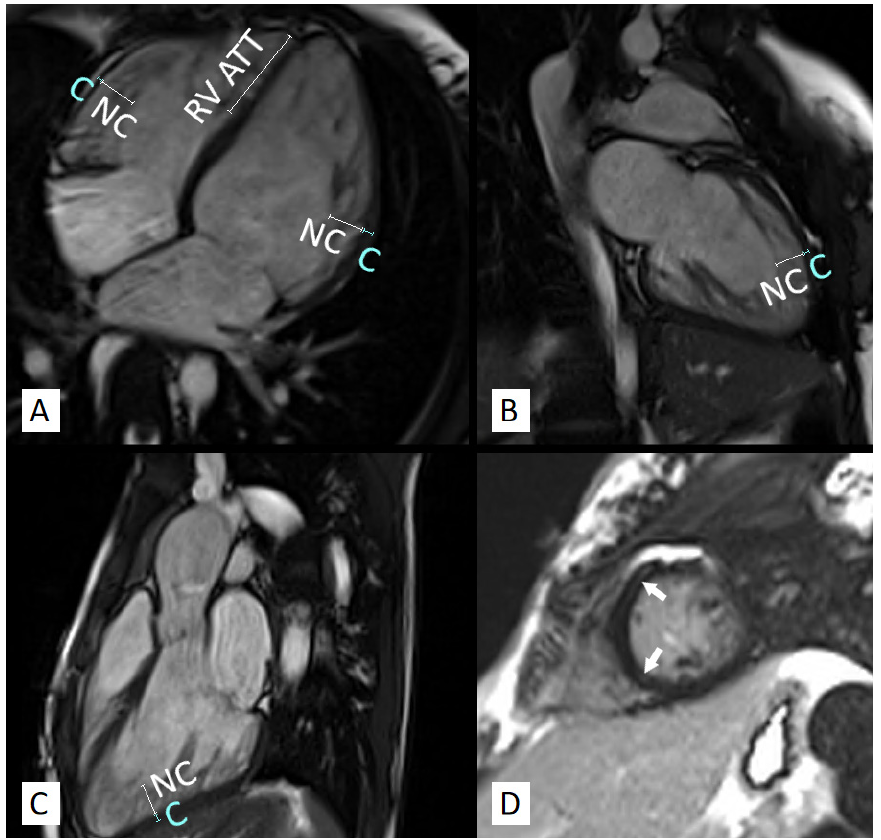
Figure 2. CMR study of a 17-year-old girl diagnosed with LVNC. The patient presented with enlarged left and right ventricles with preserved systolic function and increased trabeculations of both ventricles ( A – C ). RV apical trabecular thickness (ATT) and LV and RV noncompacted (NC) and compacted (C) layer measurements are marked on the long-axis views ( A – C ). Mid-wall late gadolinium enhancement is visible in the mid-ventricular septal segments ( D , arrows).